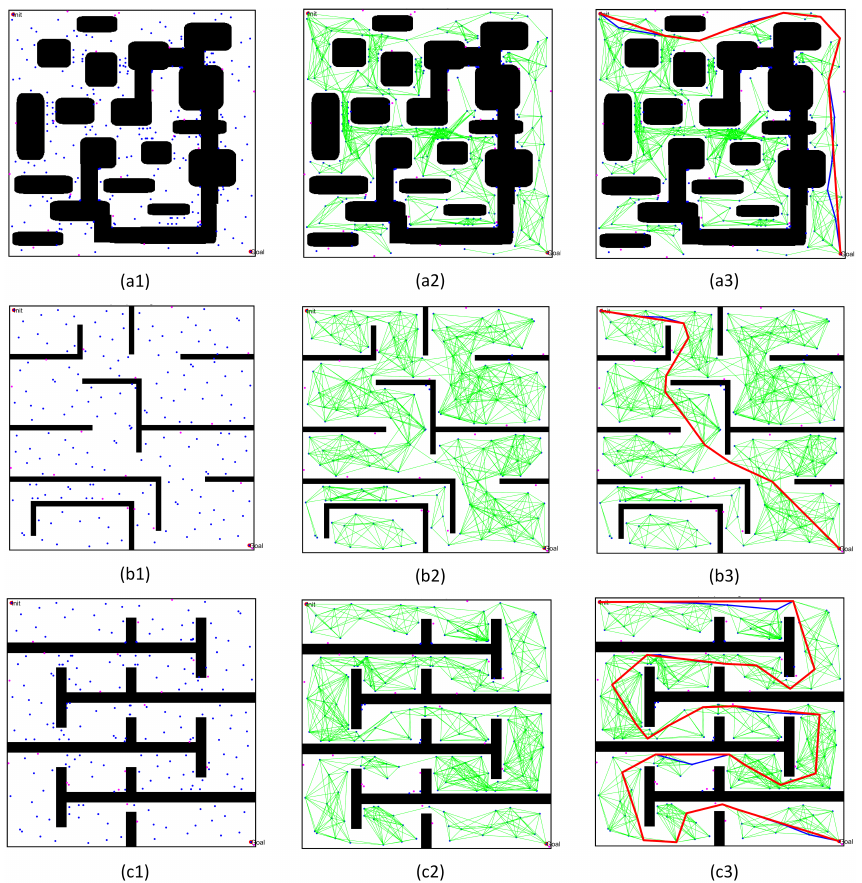
Figure 27. The results of the optimized PRM algorithm in three normal workspaces: ( a1 – a3 ) Sampling points in the three environments; ( b1 – b3 ) free space construction results in the three environments; and ( c1 – c3 ) query process results in the three